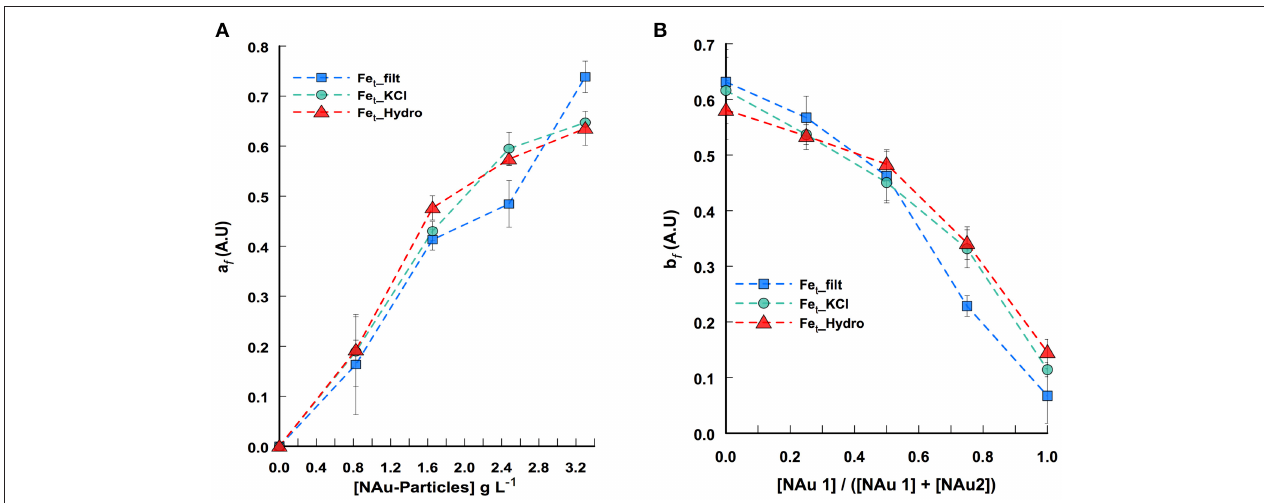
FIGURE 2 | Pattern of iron release determined from Candecomp/Parafac decomposition of the 3-way data set. (A) Fe dissolution as a function of all ratio tested (1 ≥ [NAu-1]/([NAu-1] + [NAu-2] ≥ 0) across a range of particle concentration. (B) Fe dissolution as a function of all particle concentrations (0–3.3 g L-1) tested across a range of NAu-1 and NAu-2 ratios. a f and b f indicate the contribution of the ferrospectral-Fe complex signal to the global absorbance at any nontronite concentration and at any NAu-1 to NAu-2 ratio, respectively. The symbols represent the profile of soluble Fe (squares), KCl extracted Fe (circles), hydroxylamine-KCl extracted Fe (triangles). Error bars indicate the standard error of the mean ( n =